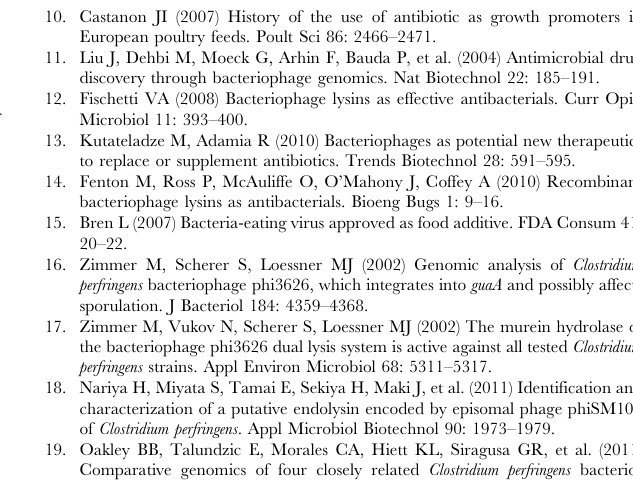
Figure S1 Representative Plaque Morphology. Bacterio- phage W CP7R was propagated in the host Clostridium perfringens Cp7 for titration and plaques were photographed with an AlphaImagerHP. Figure S2 Whole Genome similarity Comparison for